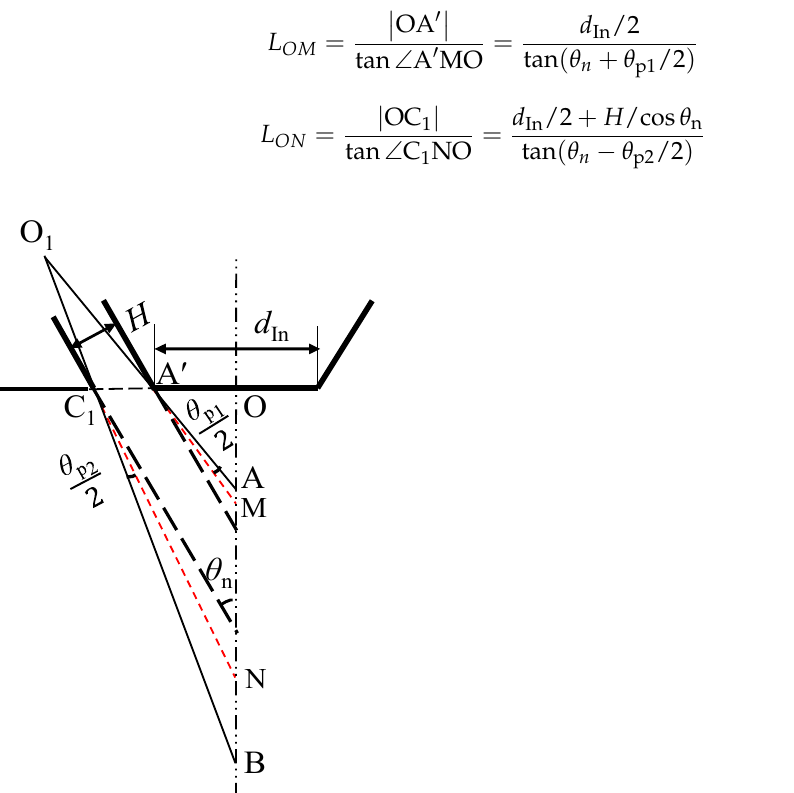
Figure 8. Geometric diagram of starting and ending positions of the waist zone.